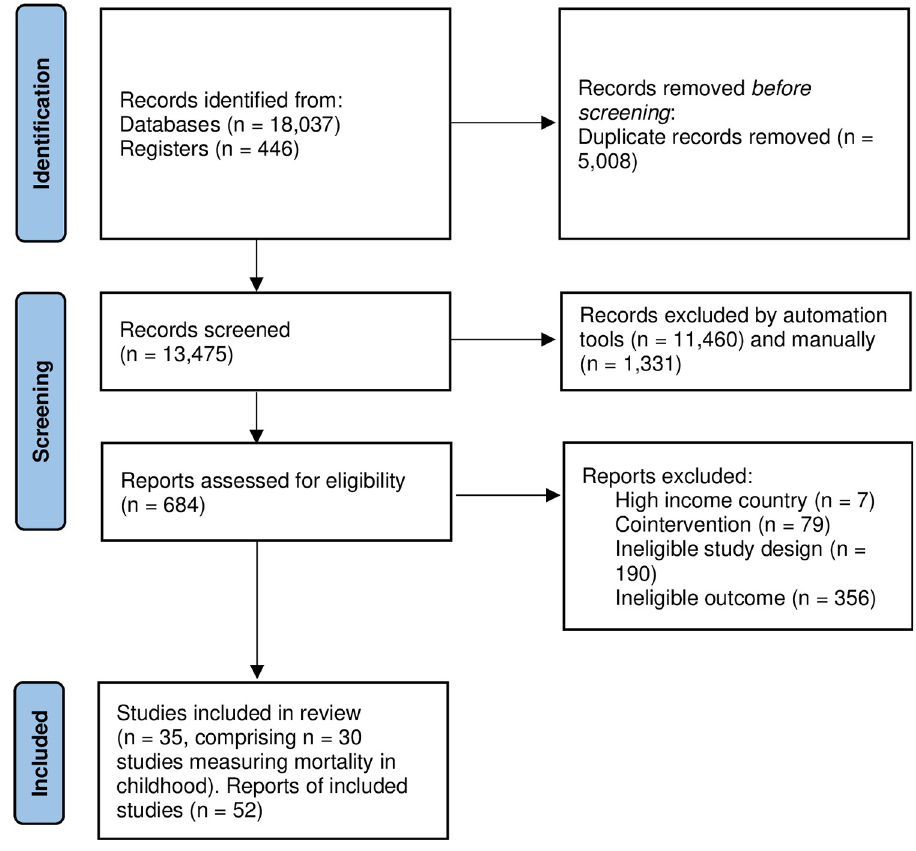
Fig 1. PRISMA study search